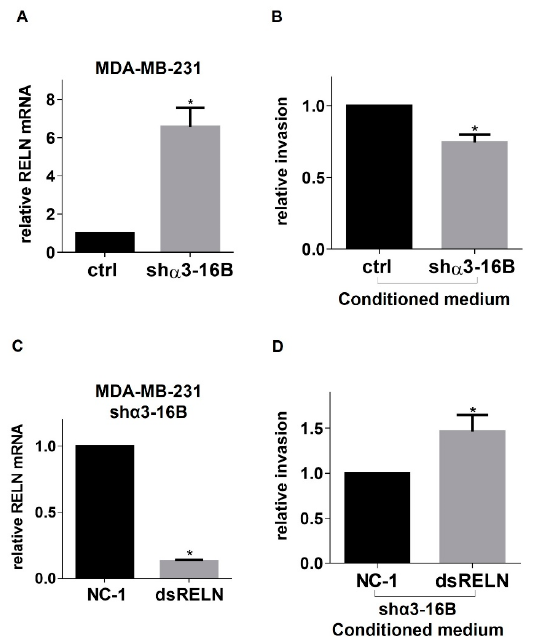
Figure 7. Conditioned medium from MDA-MB-231 cells that overexpress RELN decreases inva- sion of parental MDA-MB-231 cells. ( A ) Western blot of secreted Reelin in concentrated superna- tants of MDA-MB-231 that overexpress RELN; control, pcDNA3.1 vector. Arrows indicate previ- ously described Reelin fragments (400 kDa, 380 kDa, 180 kDa) [30,31]. ( B ) Invasive potential of MDA-MB-231 cells treated with conditioned medium from MDA-MB-231 cells transfected with a RELN over-expression plasmid, or pcDNA3.1 vector as a control, was compared using Matrigel invasion assays. Images show representative fields of DAPI-stained cells that had invaded to the undersides of transwell filters; scale bar, 100 μ M. Graph shows relative cell invasion. Data are average +/ − SEM, n = 3; * p ≤ 0.05, unpaired t -test.